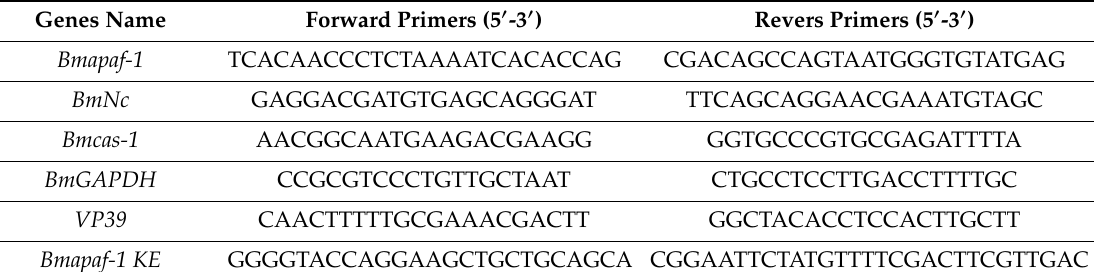
Table 1. List of primers used in this study.